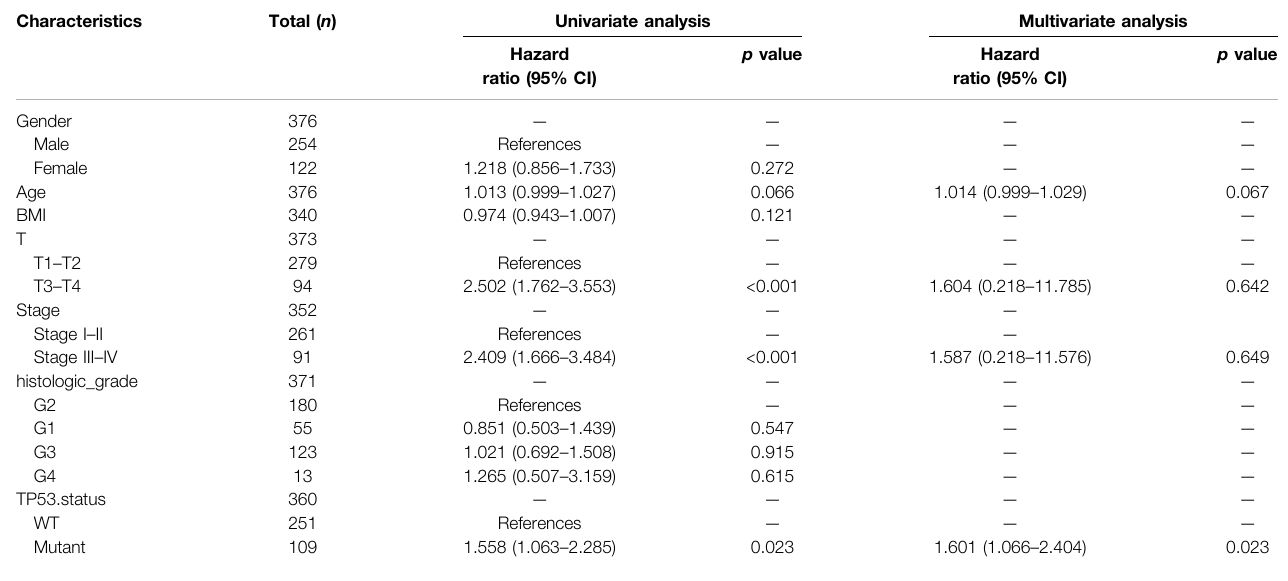
TABLE 5 | Univariate and multivariate Cox analysis